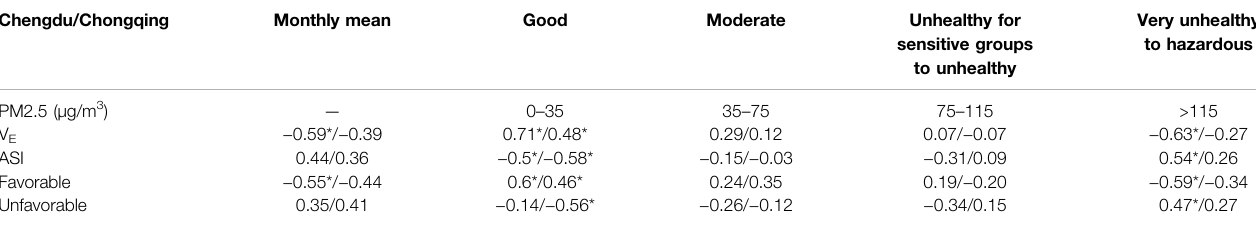
TABLE1| Correlationcoef fi cientsbetweenthedetrendPM2.5concentrationsandthefrequenciesofdifferentairqualitylevelswiththespeci fi cmetricindicatingatmospheric diffusion conditions during the winter of 2013 – 2019 in Chengdu and Chongqing (* indicates that the correlation coef fi cient is signi fi cant at the 0.01 probability level).